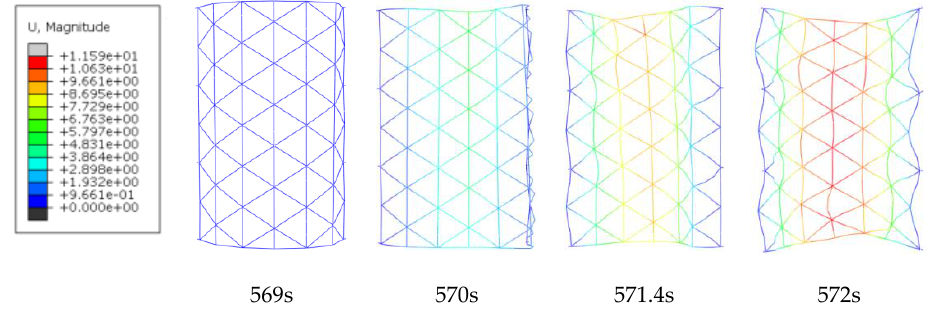
Figure 19. Structural deformation under fire location III.